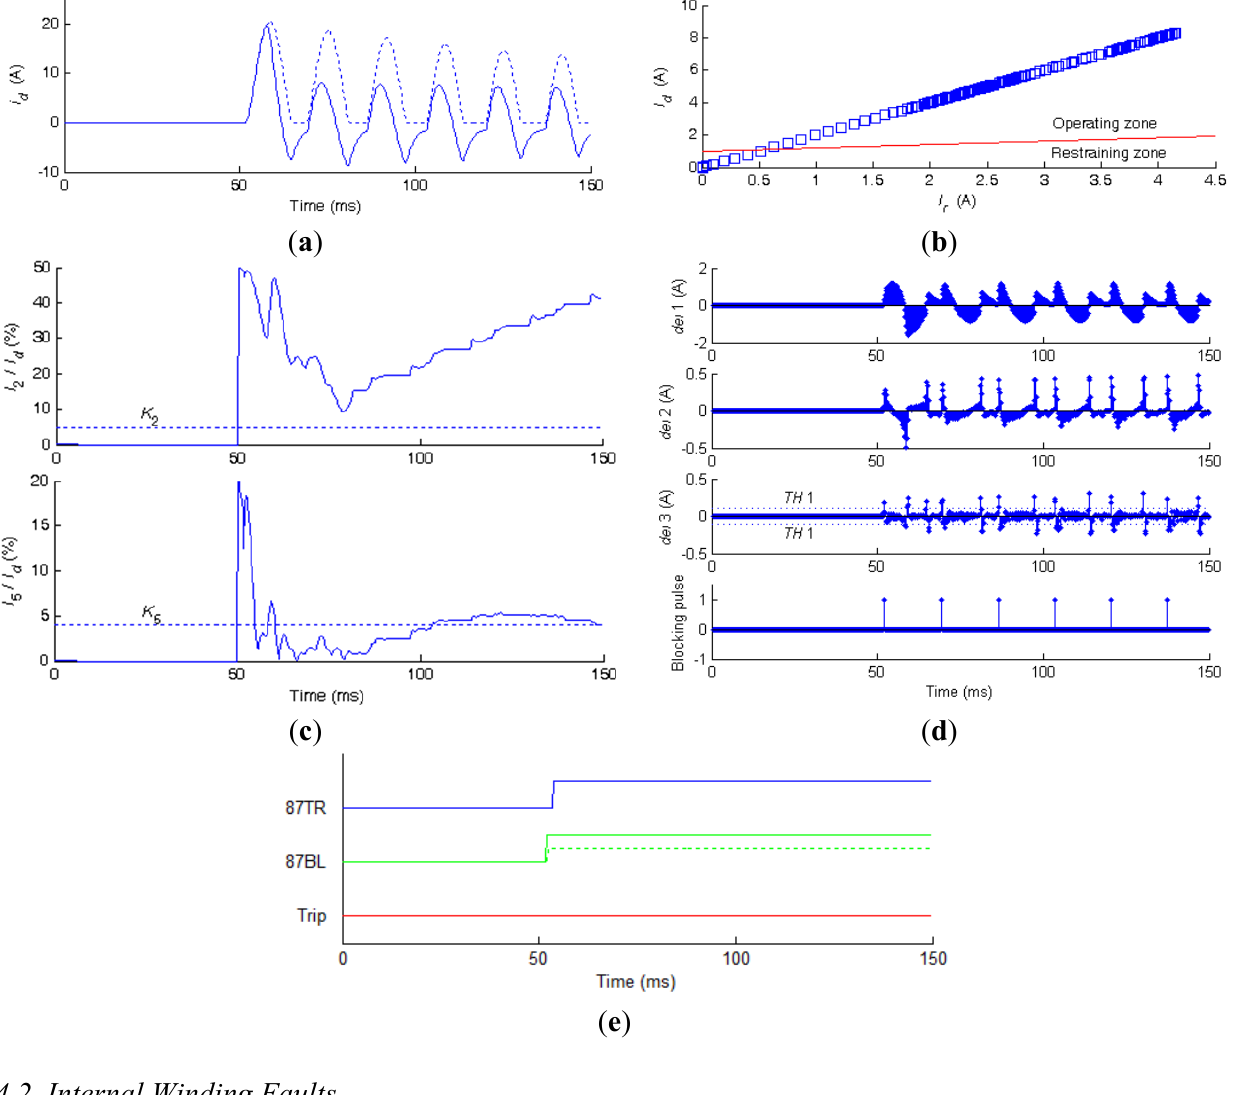
, and blocking pulse; and ( e ) 87TR, 87BL, and trip d